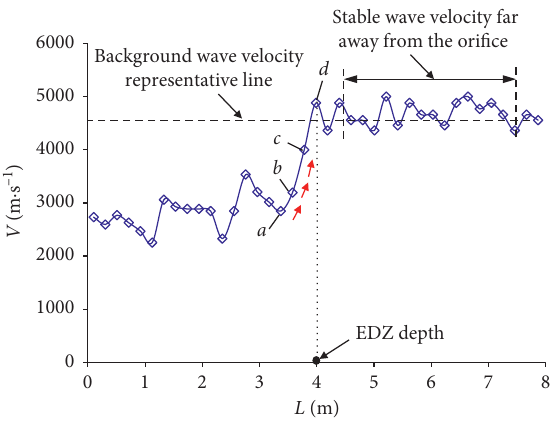
Figure 4: The proposed boundary method.